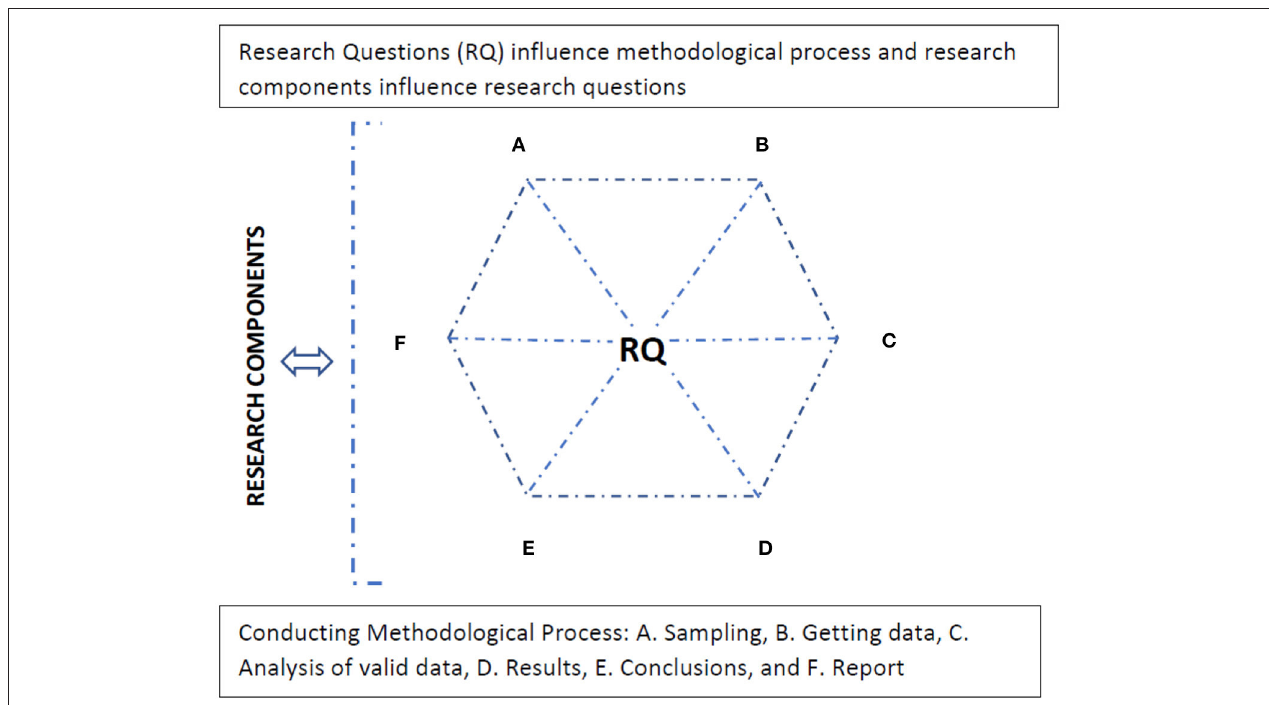
FIGURE 1 | Reciprocal relationship between Research Questions and Methodological Process.